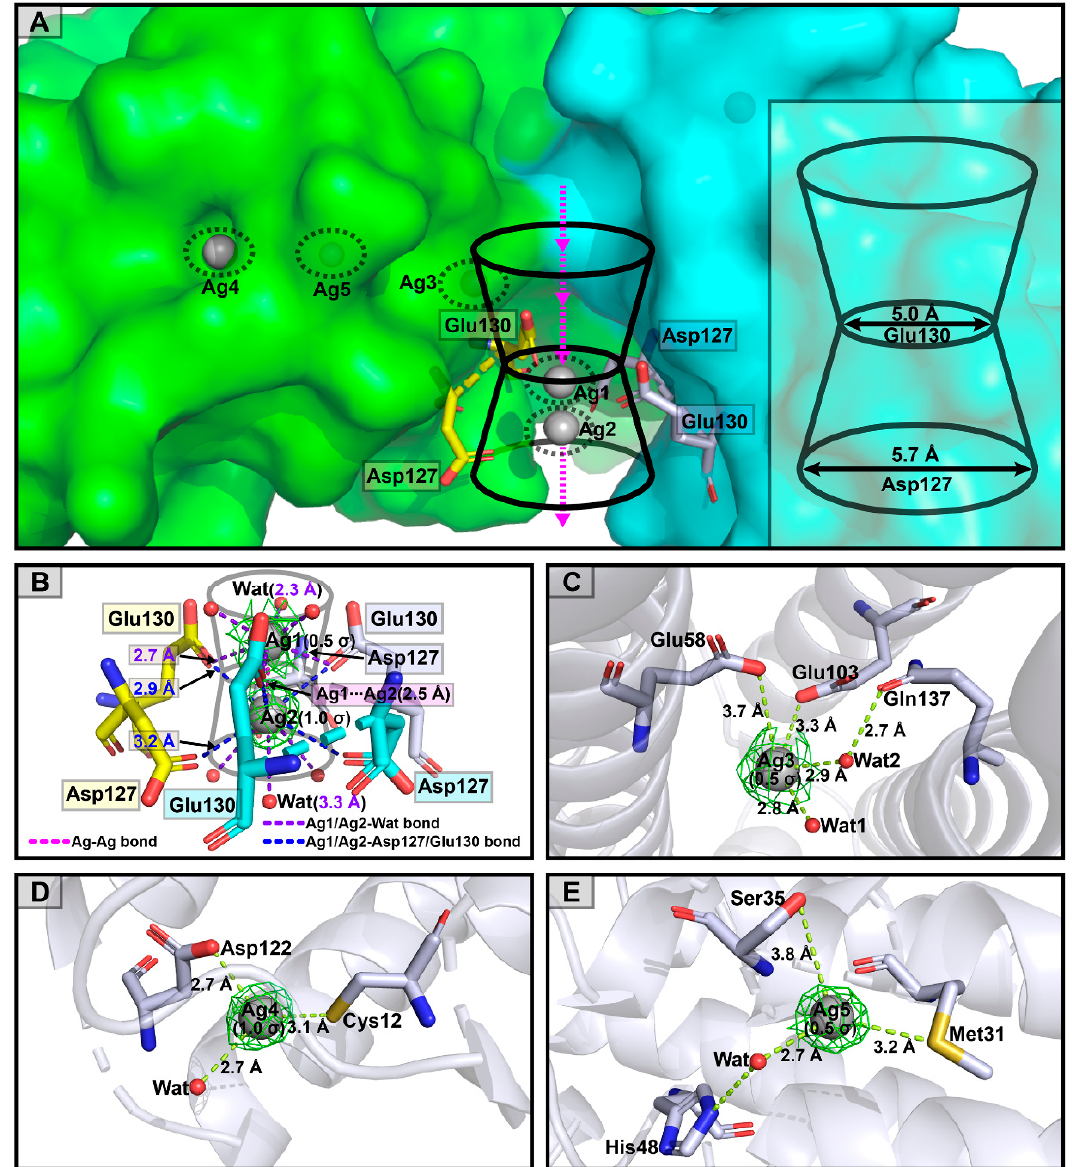
Figure 6. Silver ions traffic into the DzFer cage from the external environment. Protein residues from different subunits are indicated as sticks with yellow, cyan or blue-white carbons. Silver ions are represented as silver-grey spheres. ( A ) Stereo diagrams of the three-fold channel viewed from the outer surface of the Ag + -DzFer cage (side view). ( B ) Two Ag + ions (Ag1 and Ag2) are coordinated with Asp127 and Glu130 residues (yellow, cyan, or blue-white sticks) inside the three-fold channel of the Ag + -DzFer cage. Silver ion itself and its coordination with an amino acid residue and a water molecule is shown as carmine, blue, and purple dashed lines. ( C ) One Ag + ion (Ag3) can be observed coordinated at the ferroxidase center. ( D ) Silver coordination site on the outer surface of Ag + -DzFer cage, where one Ag + ion (Ag4) is coordinated by Cys12 and Asp122 residues from one subunit. ( E ) Another coordination of Ag + ion (Ag5) by Met31 and Ser35 residues can be observed inside one subunit. The electron densities for silver ions (green meshes) are contoured at 0.5 σ (Ag1, Ag3, and Ag5) and 1.0 σ (Ag2 and Ag4).